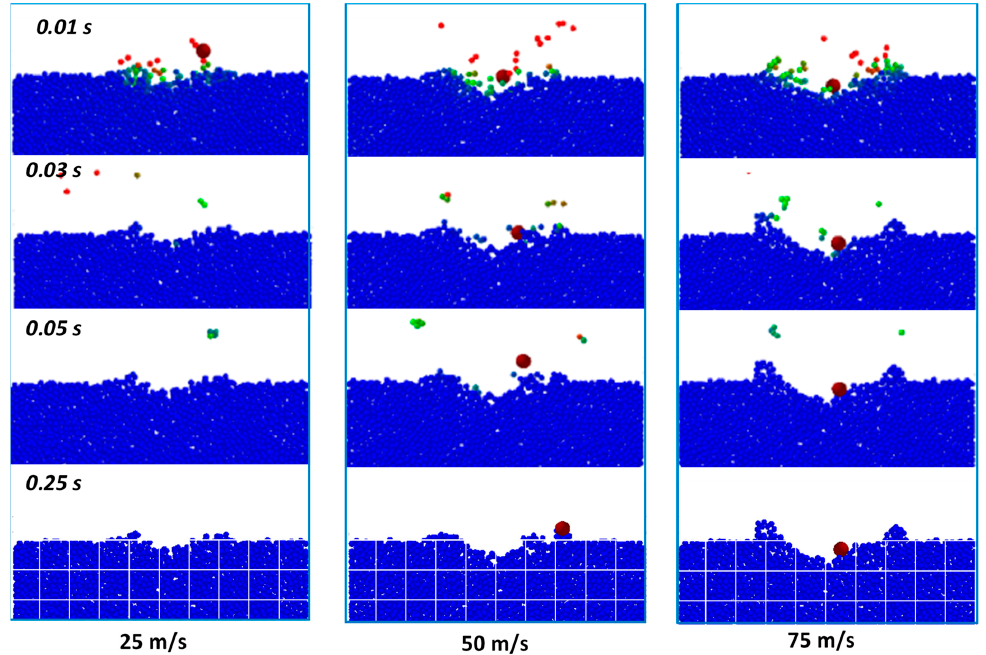
Figure 20. The process of seed penetration into cohesive soil at different speeds. Analysis of the data shows that at speeds of 25 m/s, the seed is ejected from the crater outside the modeling zone in all experiments. At a speed of 50 m/s, the probability of seed ejection is reduced to 30% and at 75 m/s to 10%. The depth of the crater at speeds of 50 and 75 m/s is also slightly greater than the penetration depth of the seed. In addition, Figure 21 provides a summary of average crater depths and average pen- etration depths on different soil types. ( a ) ( b ) Figure 21. Average crater depths ( a ) and penetration depths of pelleted seeds ( b ) on different types of soils. Thus, the following high-speed operating modes of the sowing device can be recom- mended.